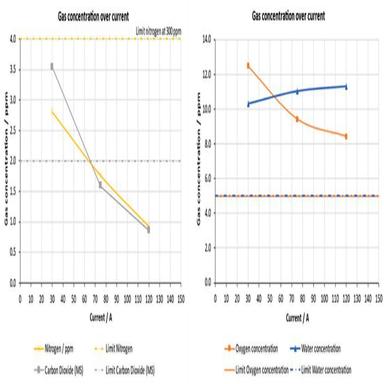
Left: Nitrogen and Carbon Dioxide concentrations in the product hydrogen, right: oxygen and water concentration in the product hydrogen.